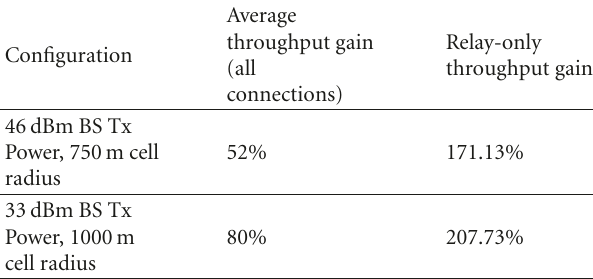
Table 2: Throughput increase as function of system configuration.